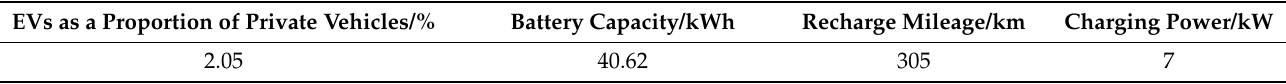
Table 1. Parameters of EVs and charging facilities.